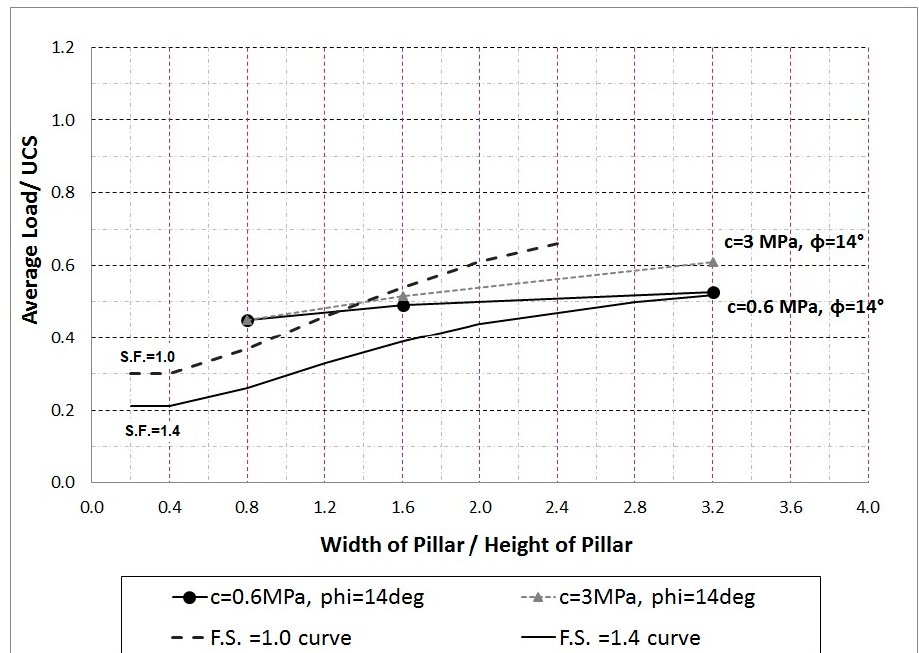
Figure 14. Effect of discontinuity cohesion on pillar strength.